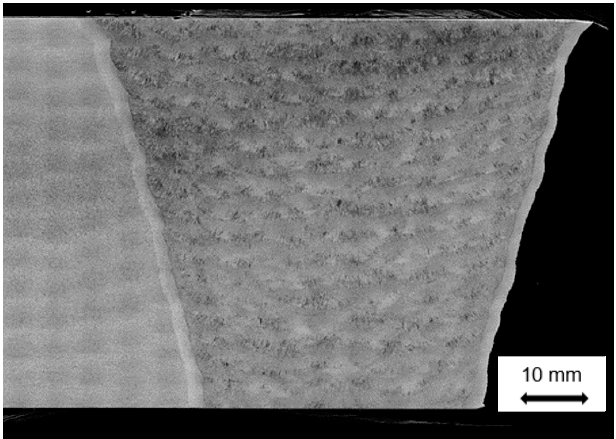
Figure 9. Macro Image from a feature sample of Grade 91 Weldment which was creep tested to failure.